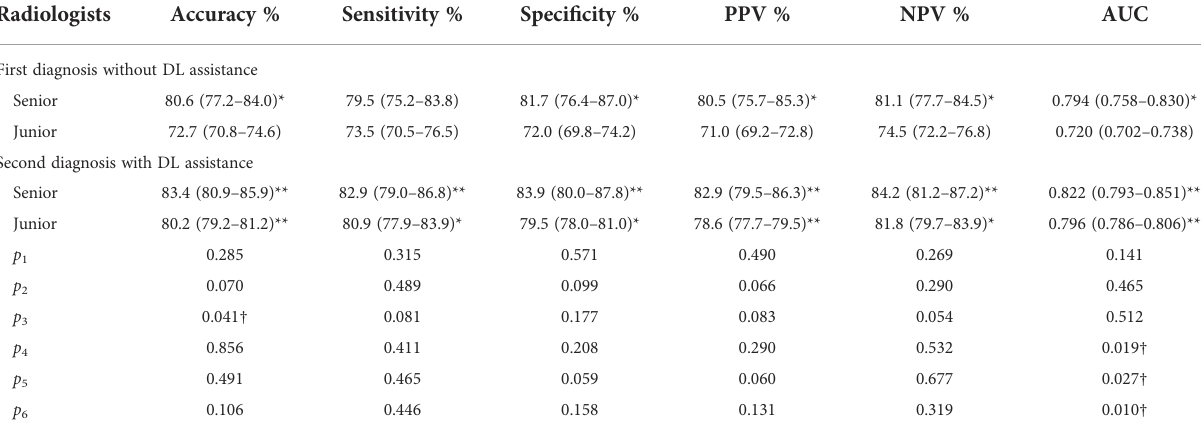
TABLE 3 The diagnostic performance of deep learning (DL), radiologists alone, and DL-assisted radiologists.